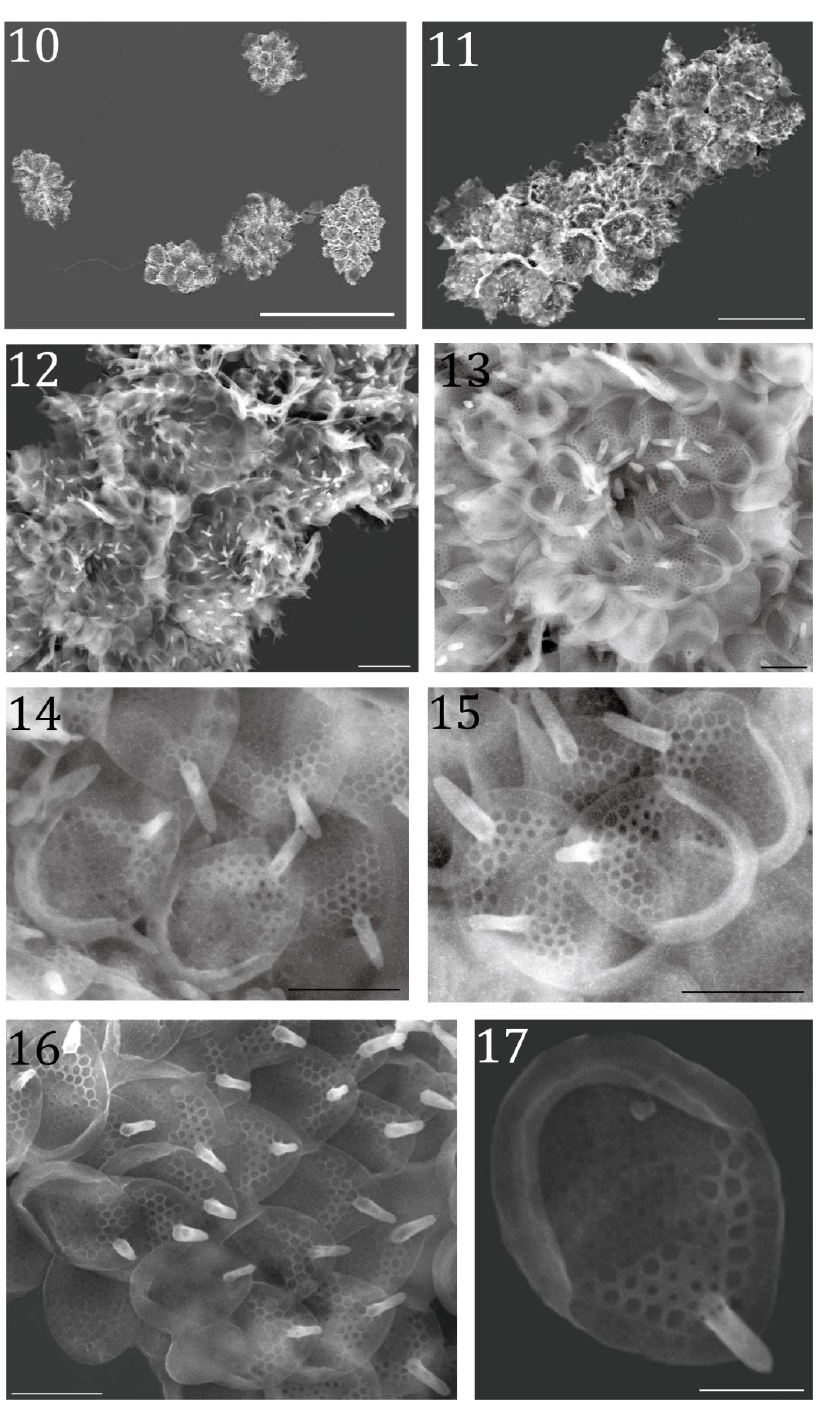
Figure 4. Morphological structures of Synura longitubularis . ( 10 ) Group of colony (SEM); ( 11 – 12 ) Colony (SEM); ( 13 ) A single cell (SEM); ( 14 – 15, 17 ) Body scales (SEM); and ( 16 ) A single body scale and spine (SEM). Scale bars: ( 10 ) = 100 μ m, ( 11 ) = 20 μ m, ( 12 ) = 5 μ m, ( 13 – 16 ) = 2 μ m, and ( 17 ) = 1 μ m. S. petersenii samples collected from the Xinpu Wetland Park (27.7024 ◦ N, 107.0180 ◦